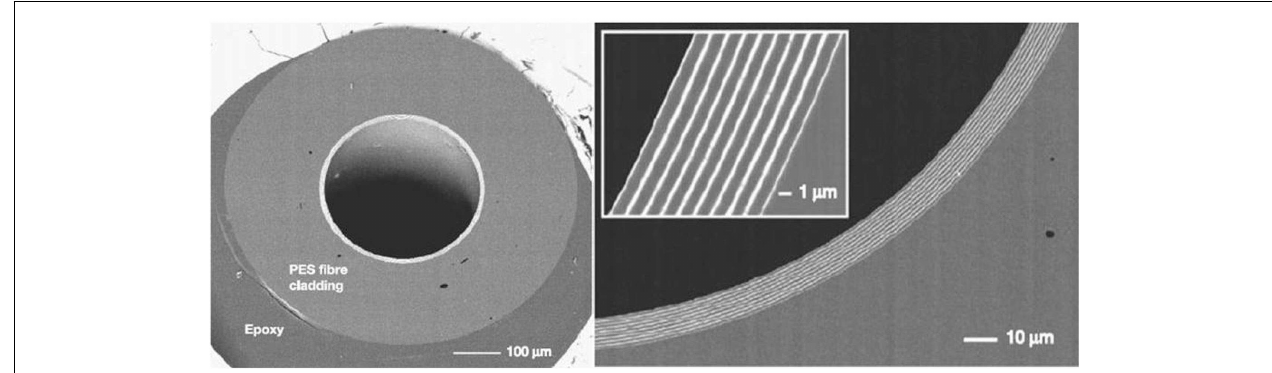
FIGURE 1 | Cross-sectional SEM micrographs at various magnifications of hollow cylindrical multi-layer fiber mounted in epoxy .The hollow-core appears black, the PES layers and cladding gray, and the As 2 Se 3 layers bright white (Temelkuran et al., 2002).